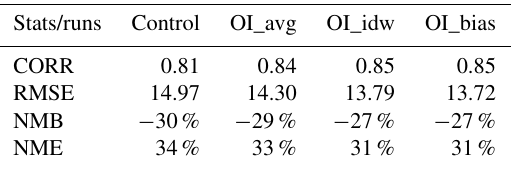
Table 2. Regional mean statistical metrics between hourly observed and simulated O 3 from 26 to 31 August 2018 over the Long Island Sound region.